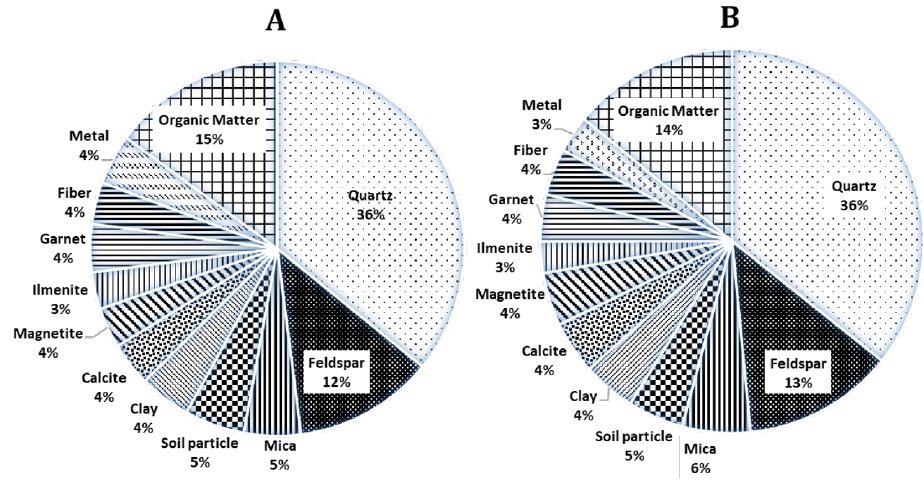
Figure 5: Average percentages of mineralogical and anthropogenic components of (A) road and (B) household dust samples.